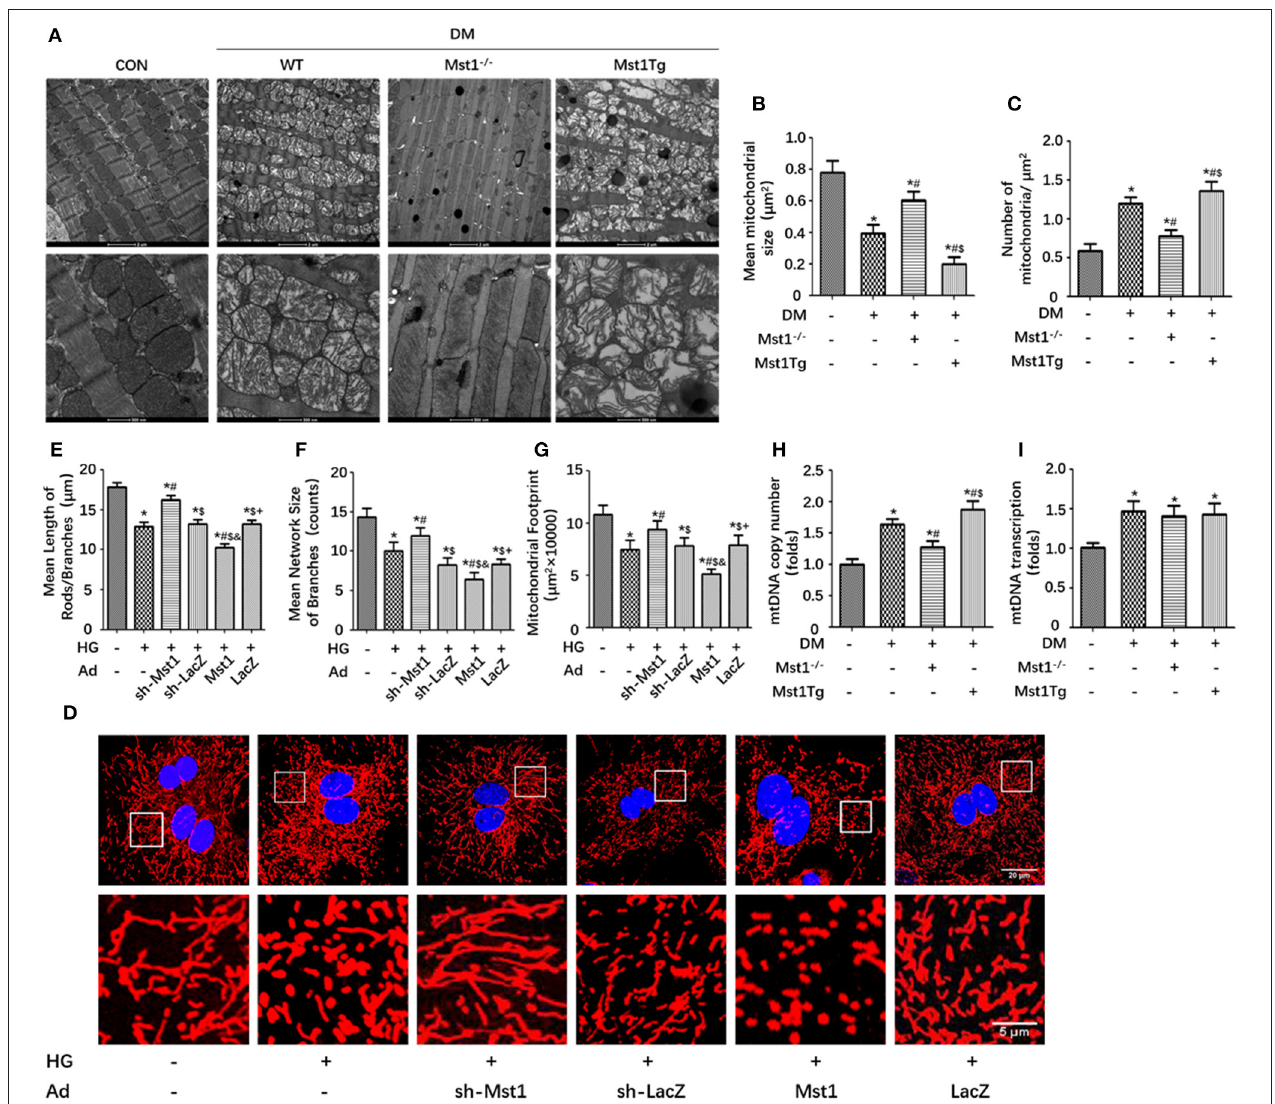
FIGURE 2 | Mst1 participates in the regulation of mitochondrial dynamics. (A) Representative images of typical damaged and different sized mitochondria (Scale bars: upper panel 2 µ m, lower panel 500nm). (B) Quantitative analysis of the mean mitochondrial size. (C) Quantitative analysis of the number of mitochondria per µ m 2 . The columns and error bars represent the means and SEM. * P < 0.05 vs. WT; # P < 0.05 vs. DM; $ P < 0.05 vs. DM + Mst1 − / − . (D) Representative images of mitochondria (MitoTracker Red) (Scale bars: upper panel 20 µ m, lower panel 5 µ m). (E) Quantitative analysis of the mean length of mitochondria rods/branches. (F) Quantitative analysis of the number of branches. (G) Quantitative analysis of the mitochondrial footprint. The columns and error bars represent the means and SEM. * P < 0.05 vs. Con; # P < 0.05 vs. HG; $ P < 0.05 vs. HG + Ad-sh-Mst1; and P < 0.05 vs. HG + Ad-sh-LacZ; and + P < 0.05 vs. HG + Ad-Mst1. (H) mtDNA copy number was assessed by complex IV segment. (I) The transcript level of mtDNA was assessed by NADH dehydrogenase subunit 1 (ND1). The columns and error bars represent the means and SEM. * P < 0.05 vs. WT; # P < 0.05 vs. DM; $ P < 0.05 vs. DM + Mst1 − / −